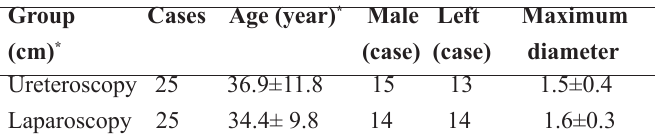
TABLE 1 - Clinical data of patients between two groups.